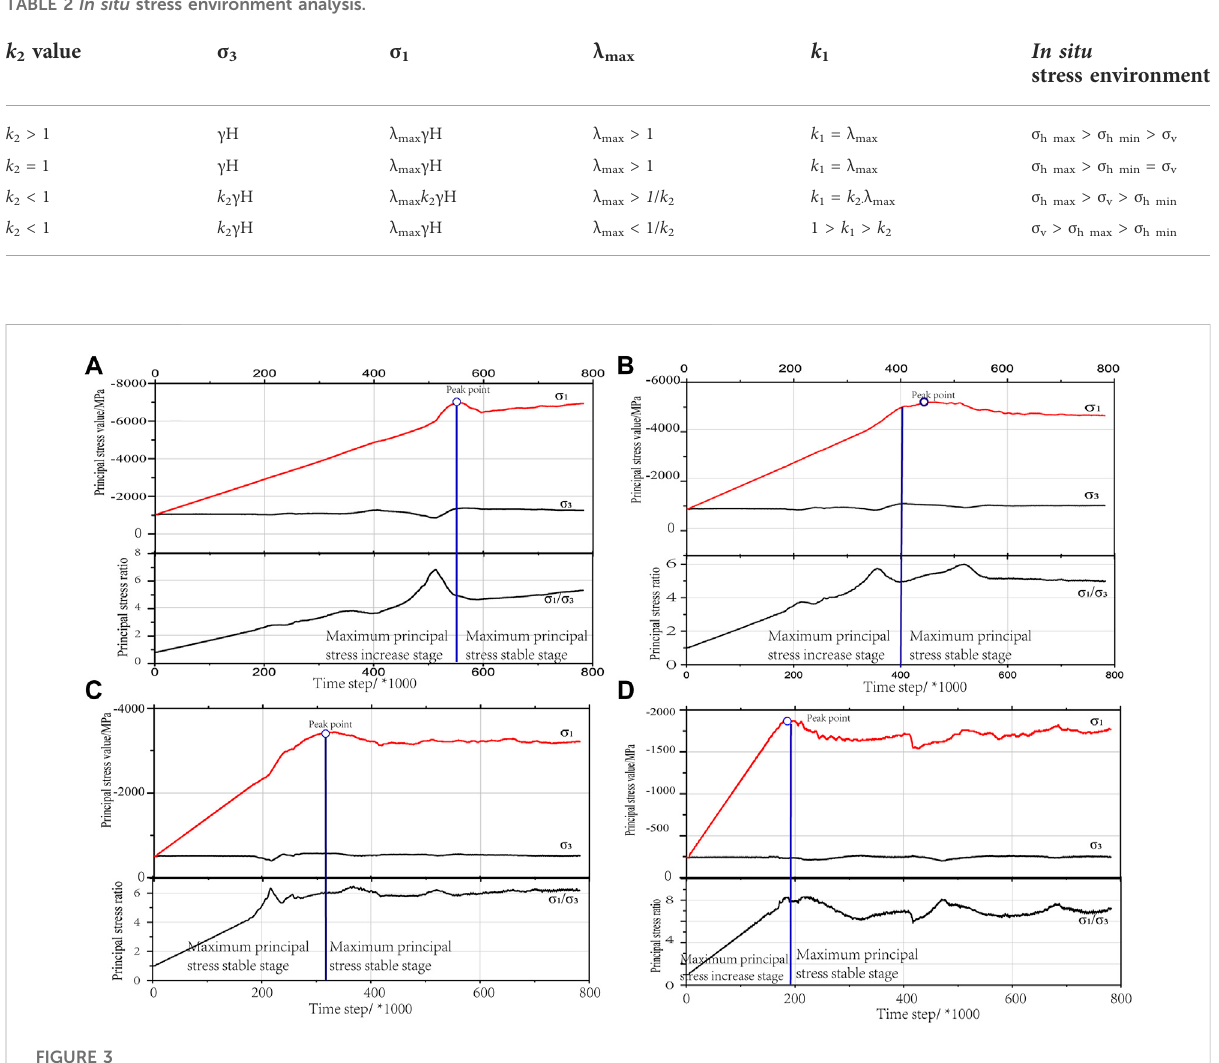
FIGURE 3 Curvesofmaximumprincipalstressatdifferentdepths.Thedepthofmeasuringpoint1is39 km (A) ,thedepthofmeasuringpoint2is29 km (B) , the depth of measuring point 3 is 19 km (C) , and the depth of measuring point 4 is 9 km (D) ; the red line in the fi gure is the change curve of the maximum principal